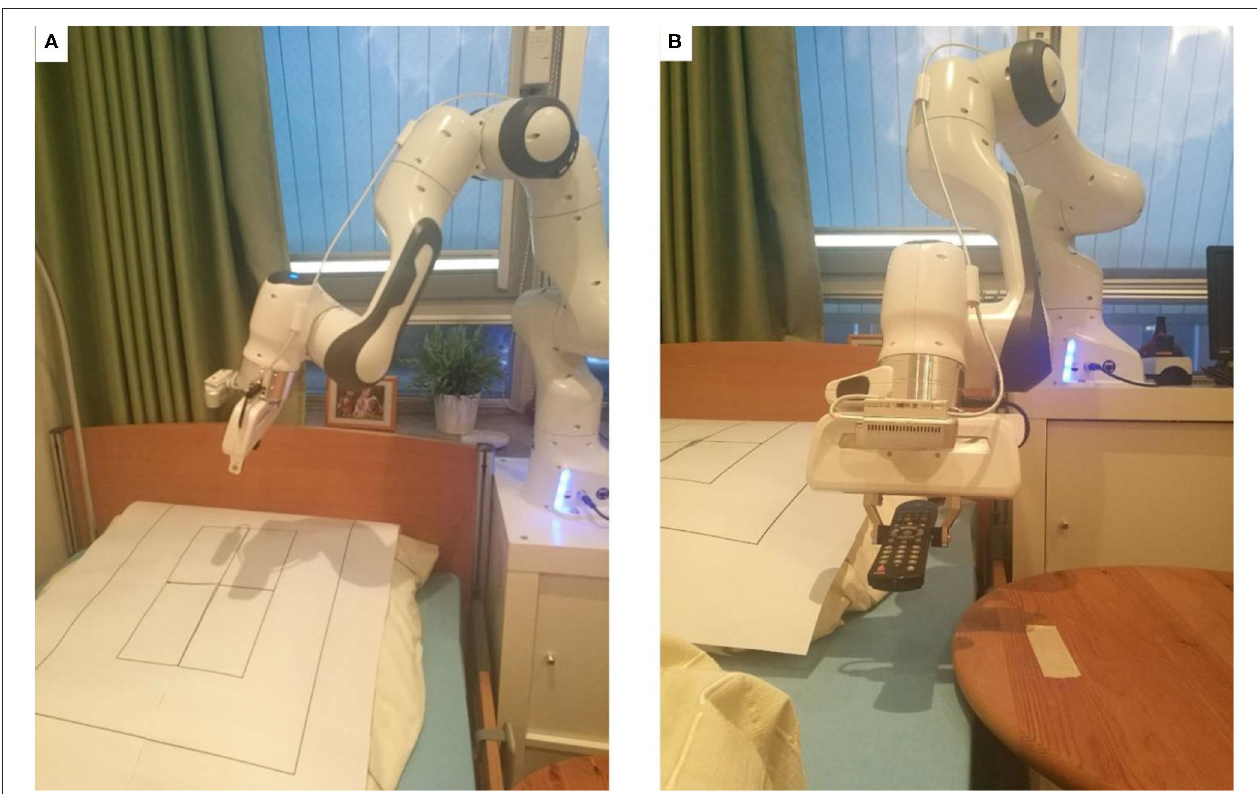
FIGURE 5 | The two tasks: (A) the task “Set Camera View” with the target cross over which the camera should be placed vertically. The distance should be chosen so that the outer black frame is no longer visible and the inner black box is completely visible. (B) The task remote control with the starting position of the remote control marked on the table and the bed as the target.